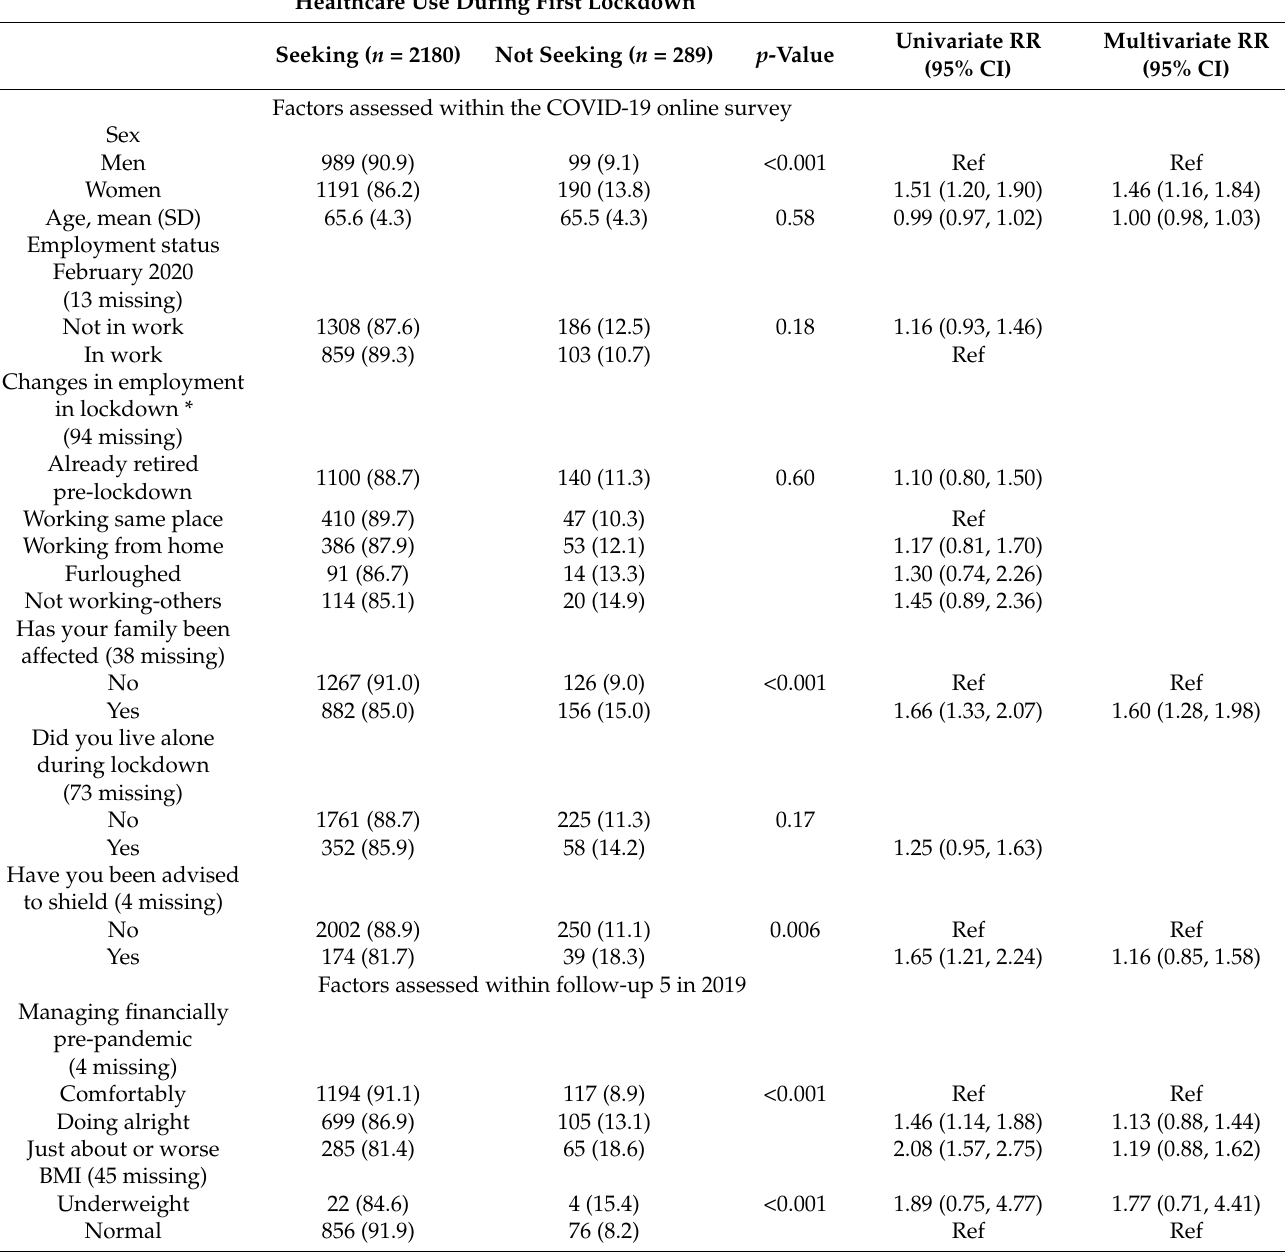
Table 1. Risk factors for not seeking